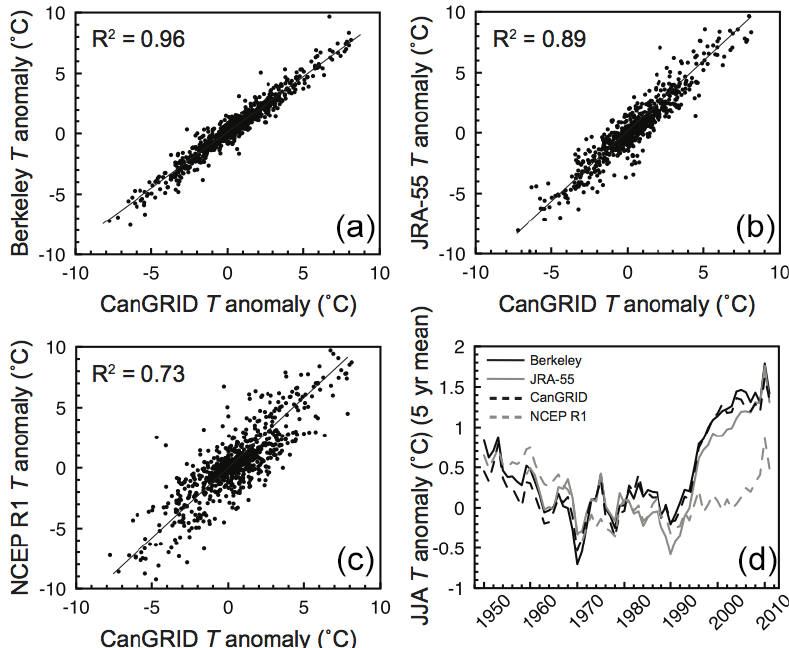
Figure 5. CanGRID 2m air temperature ( T ) anomalies plotted as a function of Berkeley Earth (a) , JRA-55 (b) , and NCEP R1 (c) anomalies. Solid lines represent linear regression lines. Data were extracted for all available years and averaged across the region 58–60 ◦ N, 295–297 ◦ E. Panel (d) shows smoothed summer (JJA) T anomalies from each dataset, between 1950 and